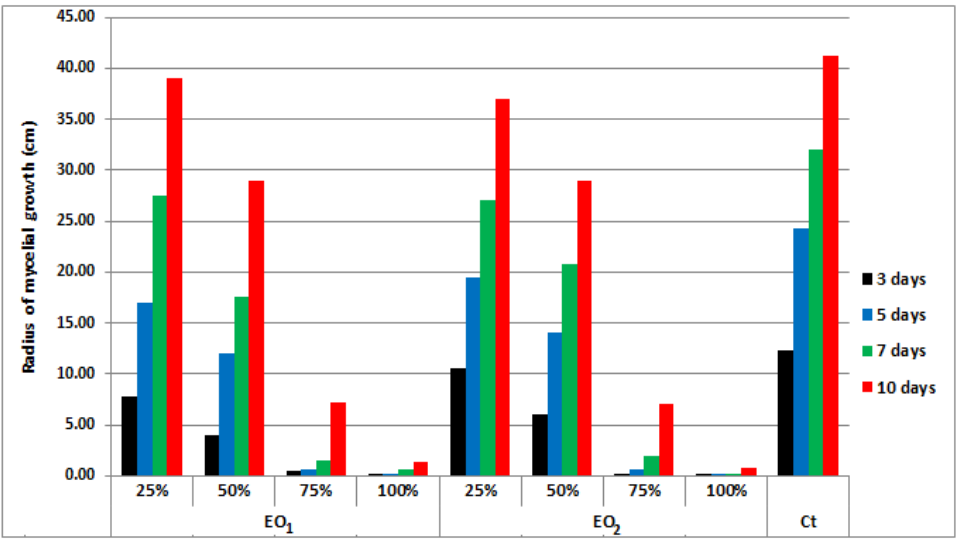
Figure 8. Basil essential oils (EOs) evaluation against the pathogen F. oxysporum on CGA medium, tested at different concentrations.